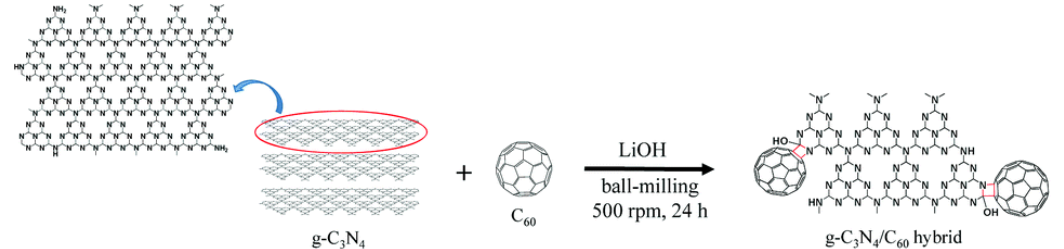
Figure 1. Schematic illustration of the mechanochemical reaction between g-C 3 N 4 and C 60 in the presence of the LiOH catalyst in a sealed ball-mill crusher. Reproduced with permission from Reference [55]. Copyright 2017, RSC.